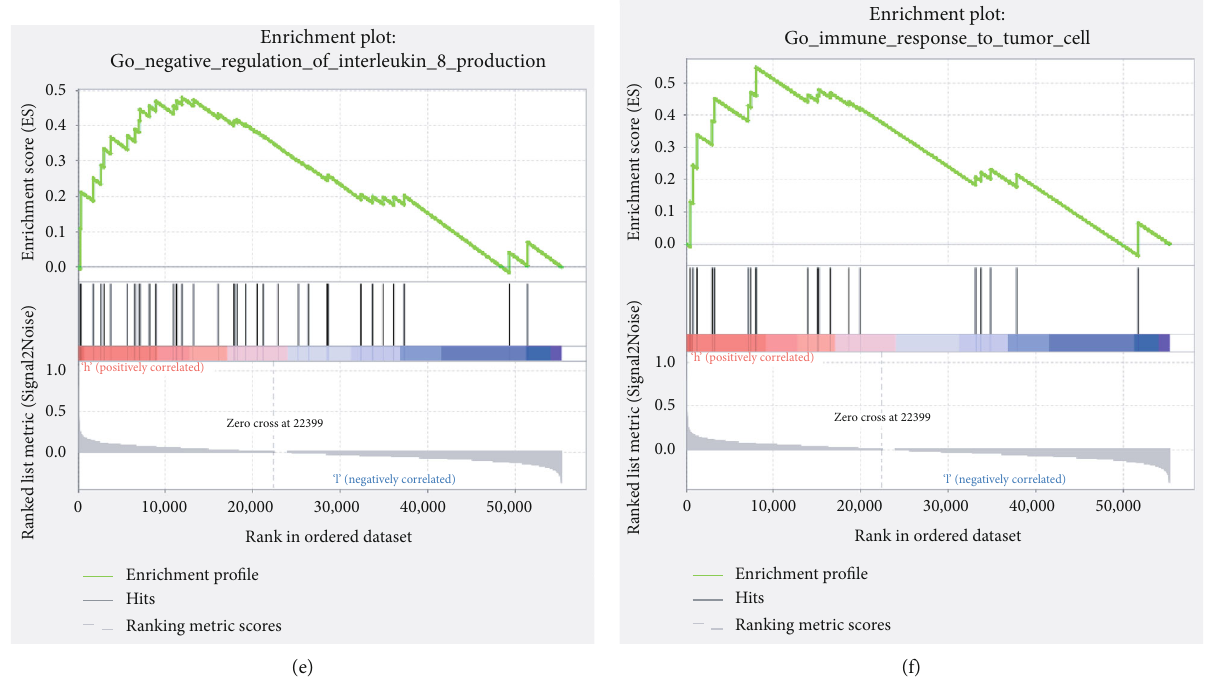
Figure 4: GSEA of KEGG pathways and biological function of DGAT1 involved in ovarian cancer. GSEA of samples with high and low expressions of DGAT1 based on TCGA